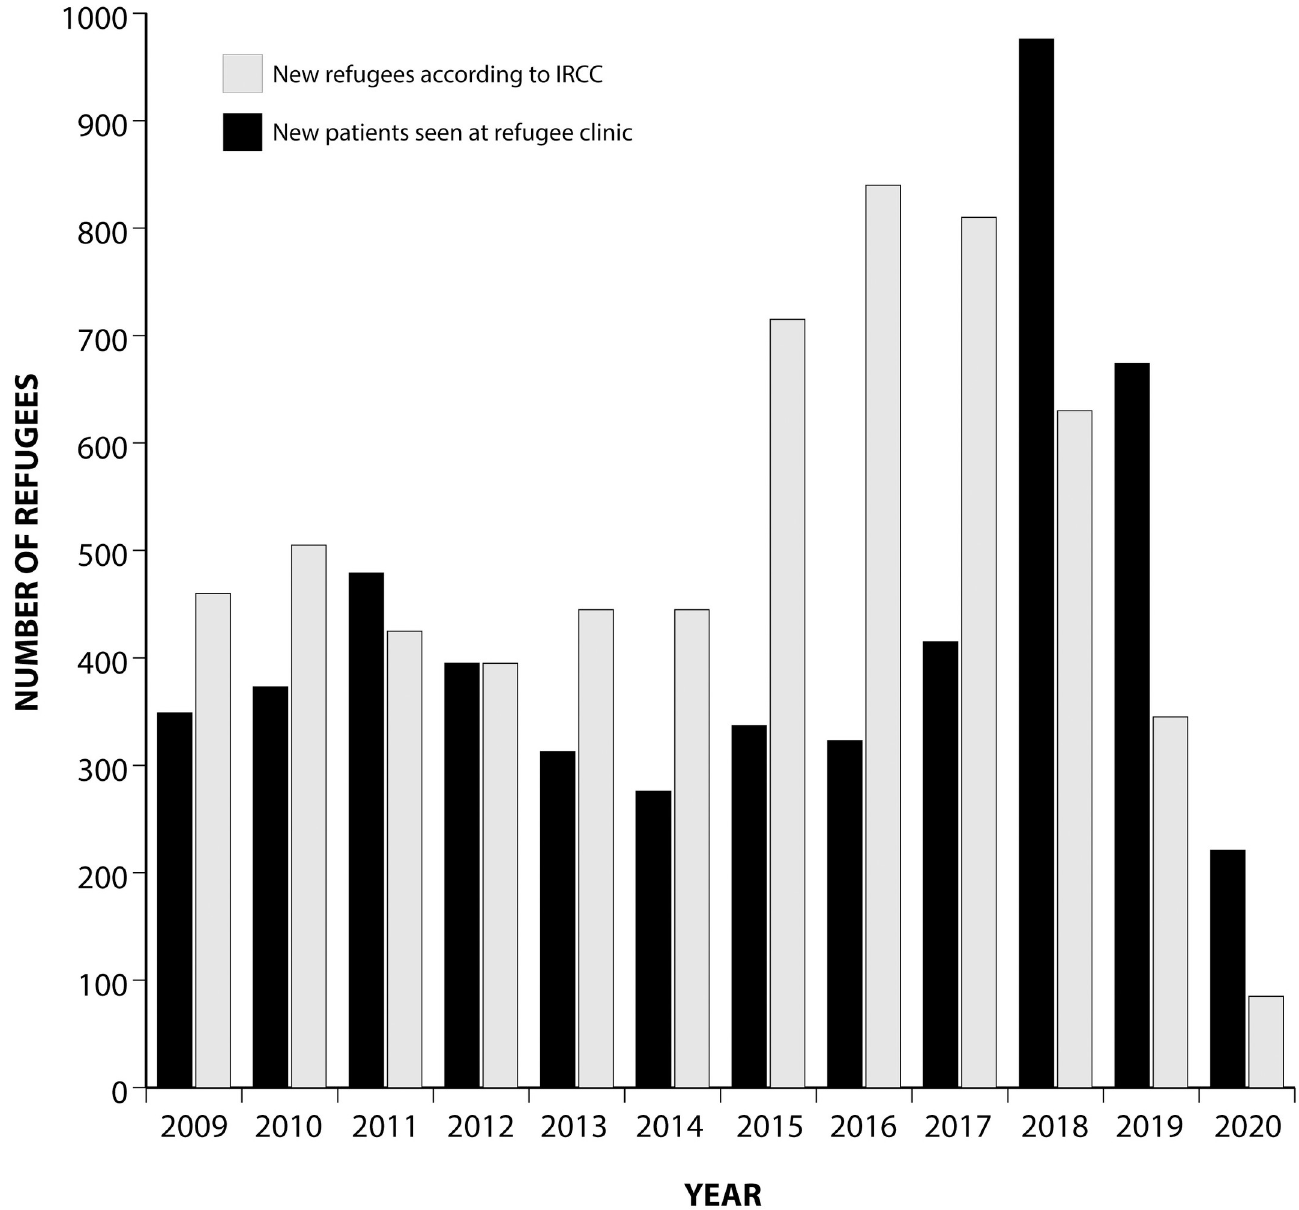
Fig 1. Number of new patients seen at the refugee clinic and of refugees settling in Estrie,